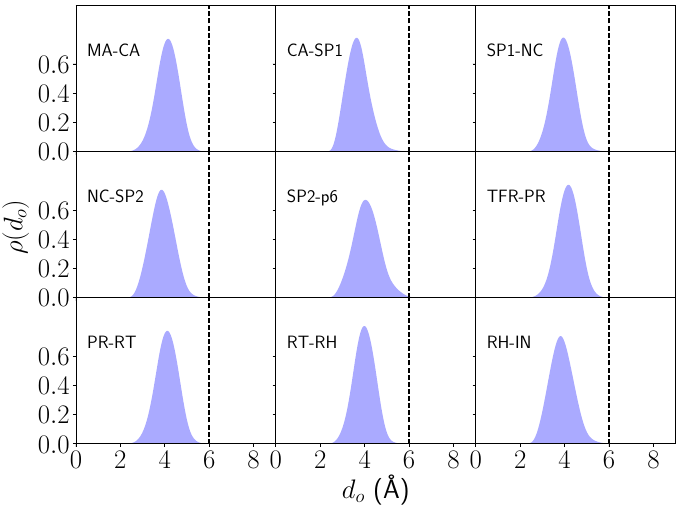
Figure 3. Normalized density distributions ( ρ ( d o ) ) of the nearest water distance ( d o ) to the midpoint of the lytic peptide bond across all enzyme-free substrate systems. The bound-unbound partition distance ( d p o ), chosen as 6 Å, is shown (dashed black